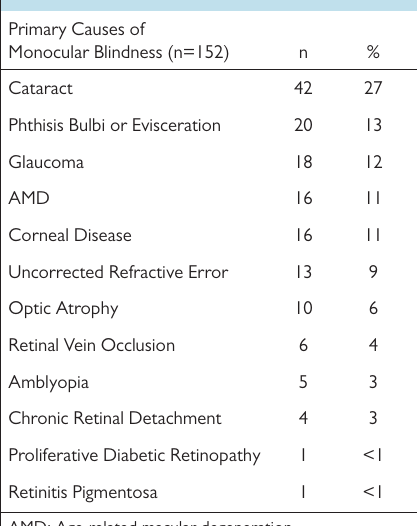
Table 5. The primary causes of monocular blindness Primary Causes of Monocular Blindness